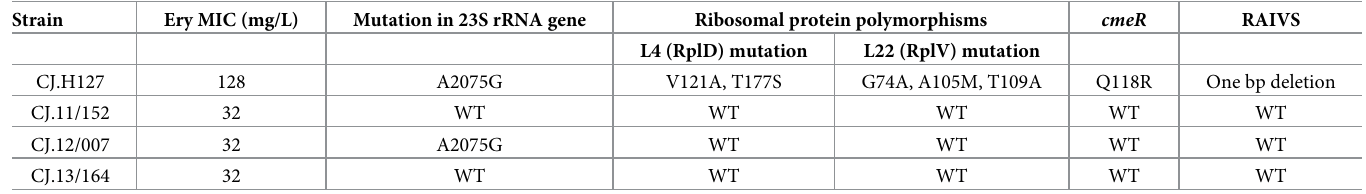
Table 4. Minimum inhibitory concentrations (MICs), 23S rRNA gene mutations, ribosomal protein substitutions and cmeRABC locus alleles in four erythromycin- resistant C . jejuni isolates. Strain Ery MIC (mg/L) Mutation in 23S rRNA gene Ribosomal protein polymorphisms cmeR RAIVS L4 (RplD)